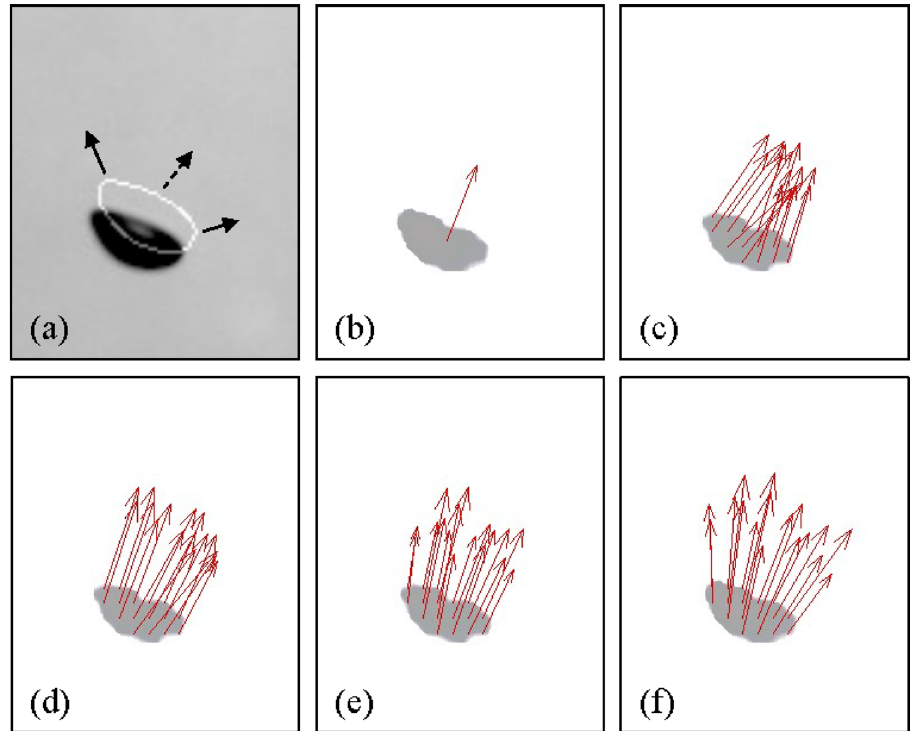
Figure 5. Evaluation of the velocity of a single bubble (size of 3.5 mm): ( a ) the instant raw image with the bubble morphology at the next time step (after 30 ms) overlapped with a solid line; ( b ) result of the PTV; ( c ) Lukas-Kanade method; ( d ) Farnebäck method; ( e ) pre-trained CNN-based model; ( f ) fine-tuned CNN-based model. The gray shadow in ( b–f ) corresponds to the bubble shadow in ( a